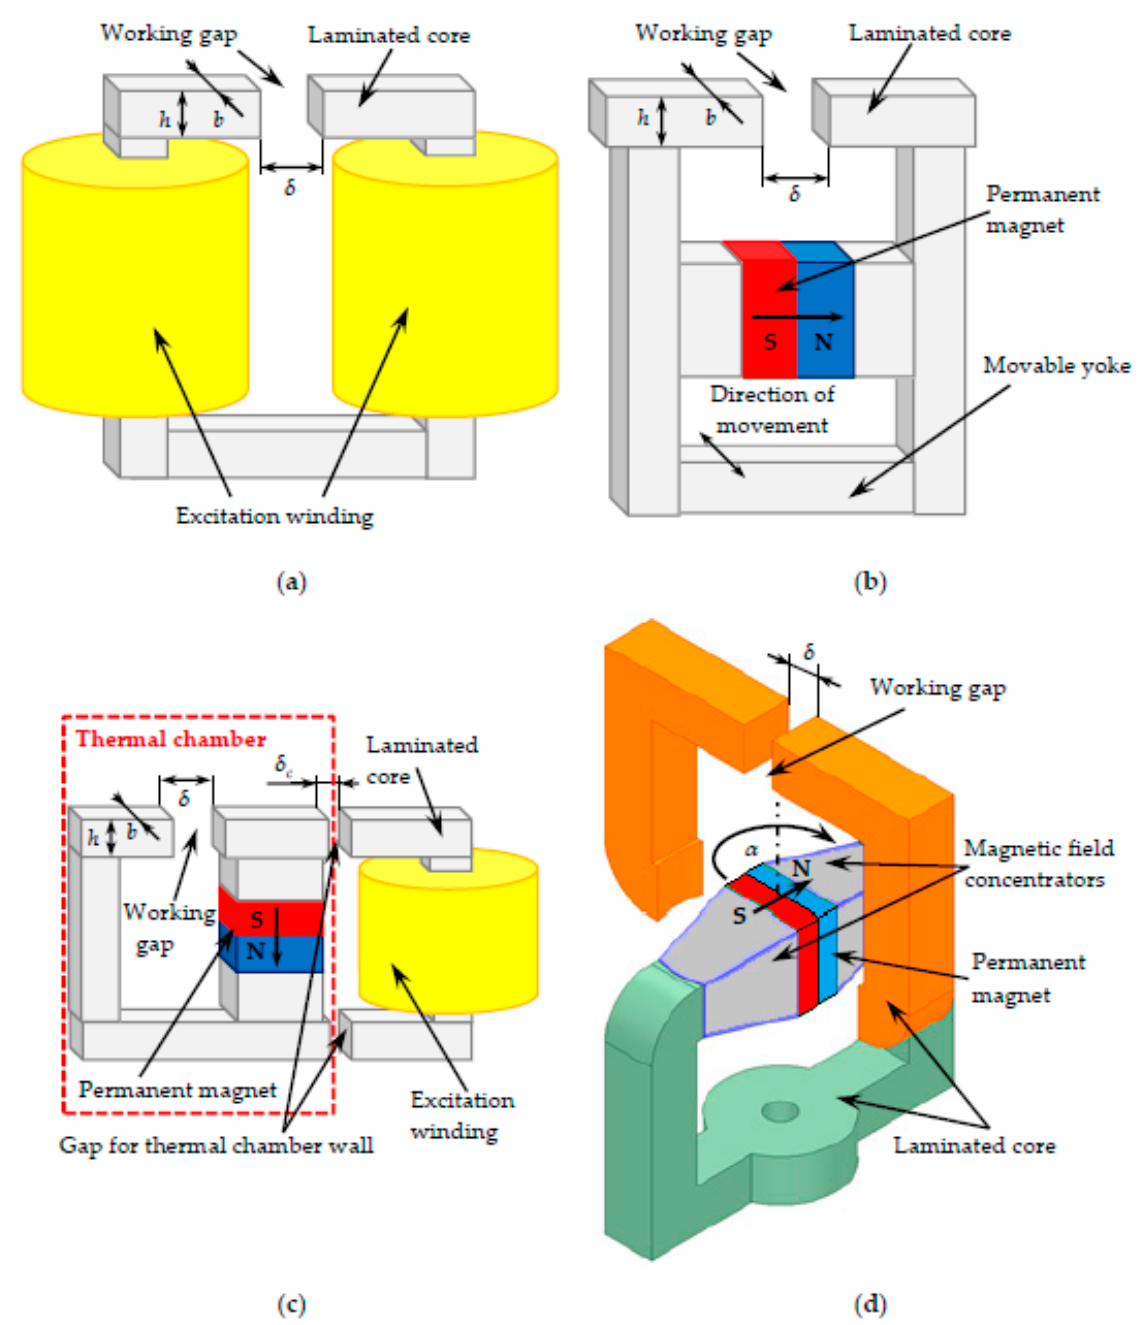
Figure 2. Exciters with: ( a ) a winding generating magnetic field, ( b ) magnetic field generated by permanent magnet and controlled by linear position of the movable yoke, ( c ) a hybrid excitation system, ( d ) magnetic field generated by permanent magnet and controlled by rotating movable element.